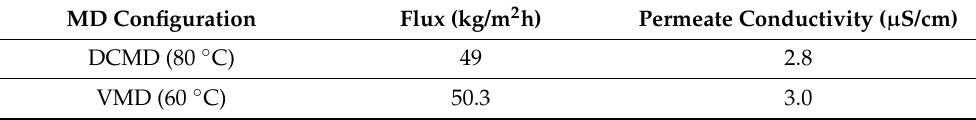
Table 2. Comparison of DCMD and VMD operating on the 80 g/L brine.